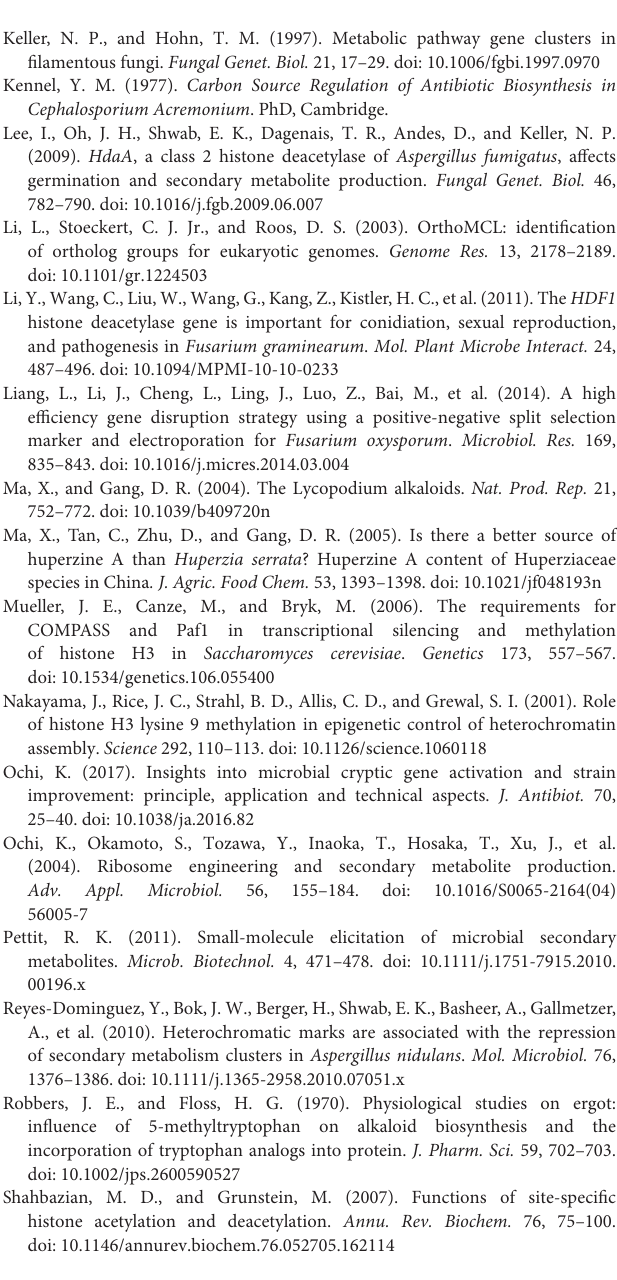
Table S1 | Gene-knockout and retro-complementation primers. Table S2 | Gene annotation and expression of P. polonicum hy4. Table S3 | Gene annotation and expression of C. gloeosporioides Cg01. Table S4 | KEGG pathway enrichment analysis of the differentially expressed genes between the induced group and the control group in P. polonicum hy4. Table S5 | KEGG pathway enrichment analysis of the differentially expressed genes between the induced group and the control group in C. gloeosporioides Cg01.